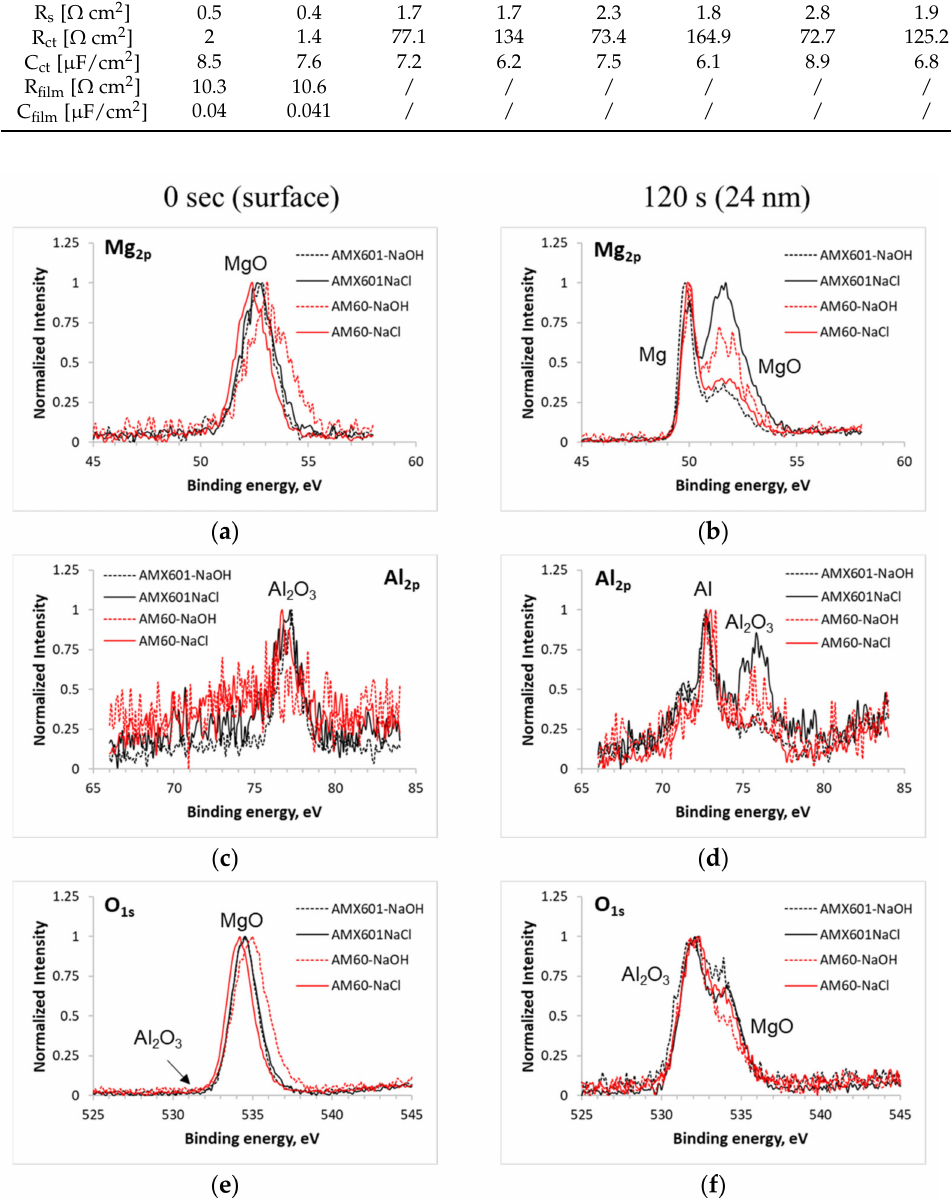
Figure 13. XPS analysis of corrosion products of AM60 and AMX601 alloys after different immer- sion periods in 3.5 wt% NaCl solution saturated with Mg (OH) 2 and NaOH solution (pH ≈ 10.5): ( a ) Mg 2p 0s etching; ( b ) Mg 2p 120s etching; ( c ) Al 2p 0s etching; ( d ) Al 2p 120s etching; ( e ) O 1s 0s etching; ( f ) O 1s 120s